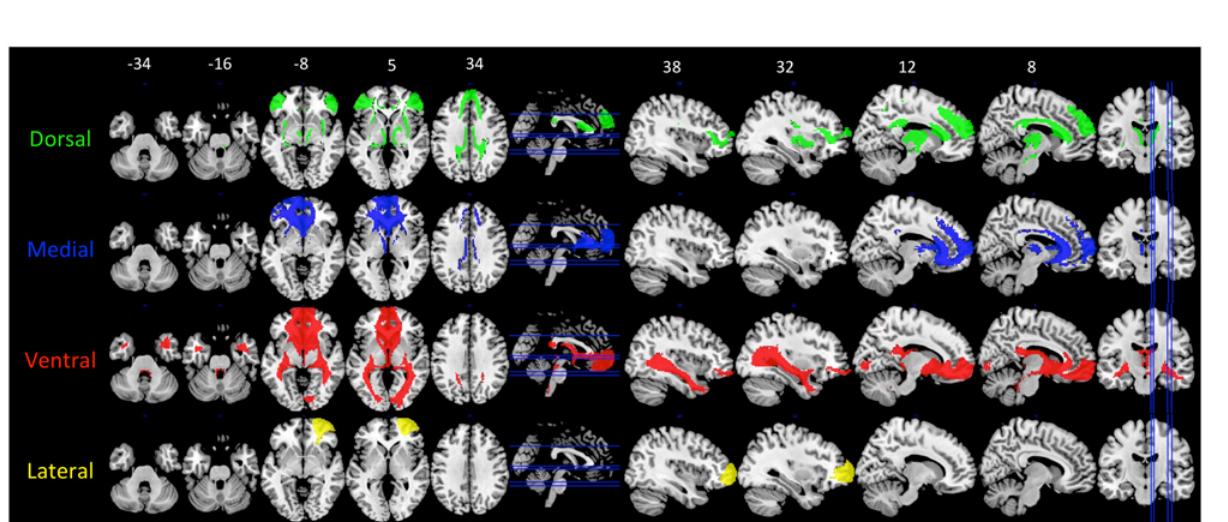
Fig 7. Tracts that had significantly greater connectivity strength to a designated cluster compared to the average of all other cluster tracts for the right hemisphere K = 7 solution. Comparisons were cluster-level FWE-corrected to p < .01. The color of the tract and the label corresponds to the color of the cluster in Fig 2. Axial slices are shown in the left column, with slice locations marked on the sagittal slice with a blue line. Sagittal slices are shown in the right column, with slice locations marked on the axial slice with a blue line. MNI coordinates for the z -axis (axial slices) and x -axis (sagittal slices) are shown above the top